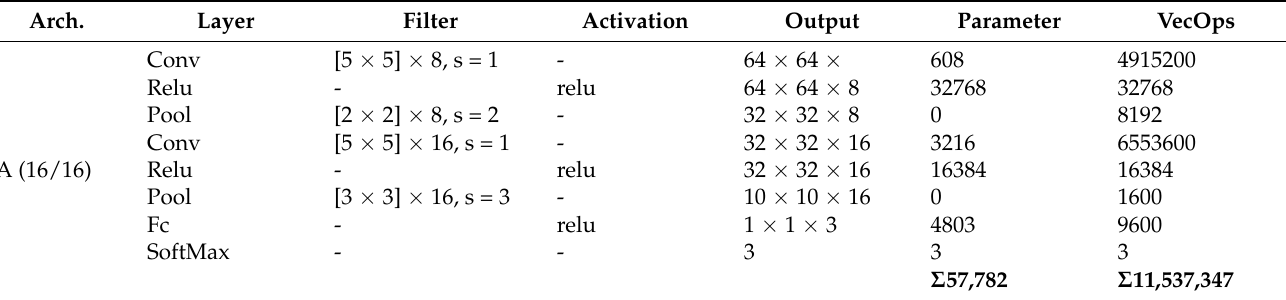
Table A1. Layer structures and parameter counts of four different CNN architectures used in